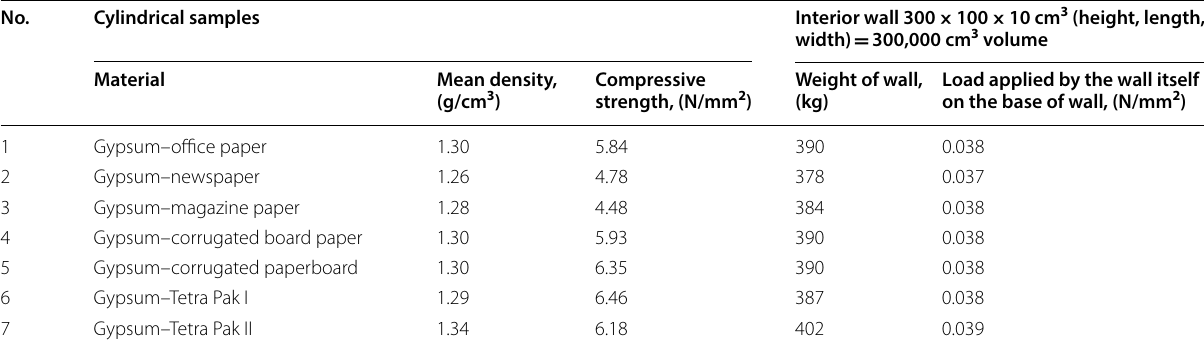
Table 2 Compressive strength of cylindrical samples compared with the maximum load applied on the base of an interior wall made of the corresponding experimental material No.